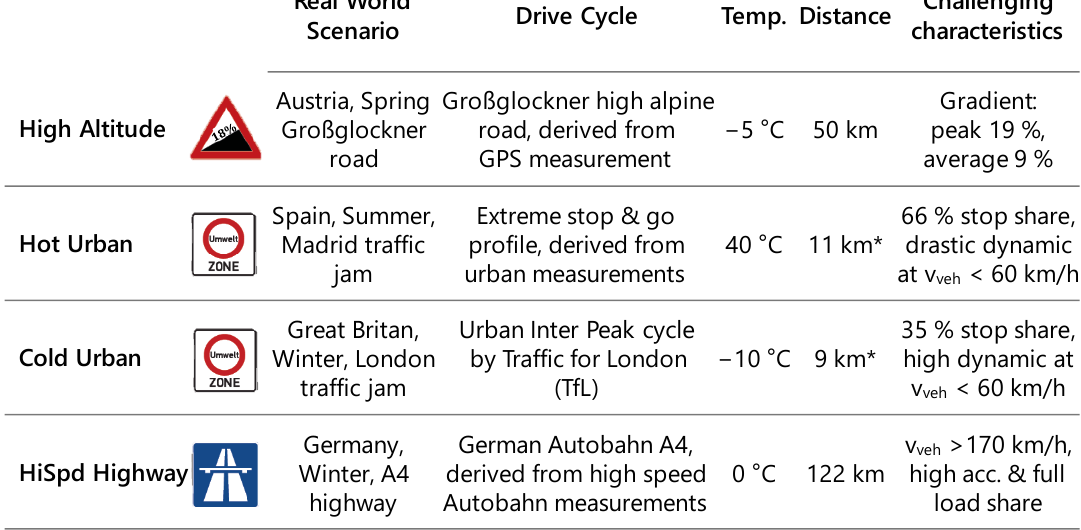
Figure 6. Challenging real-world scenarios for developing and testing Euro 7 concepts [43].